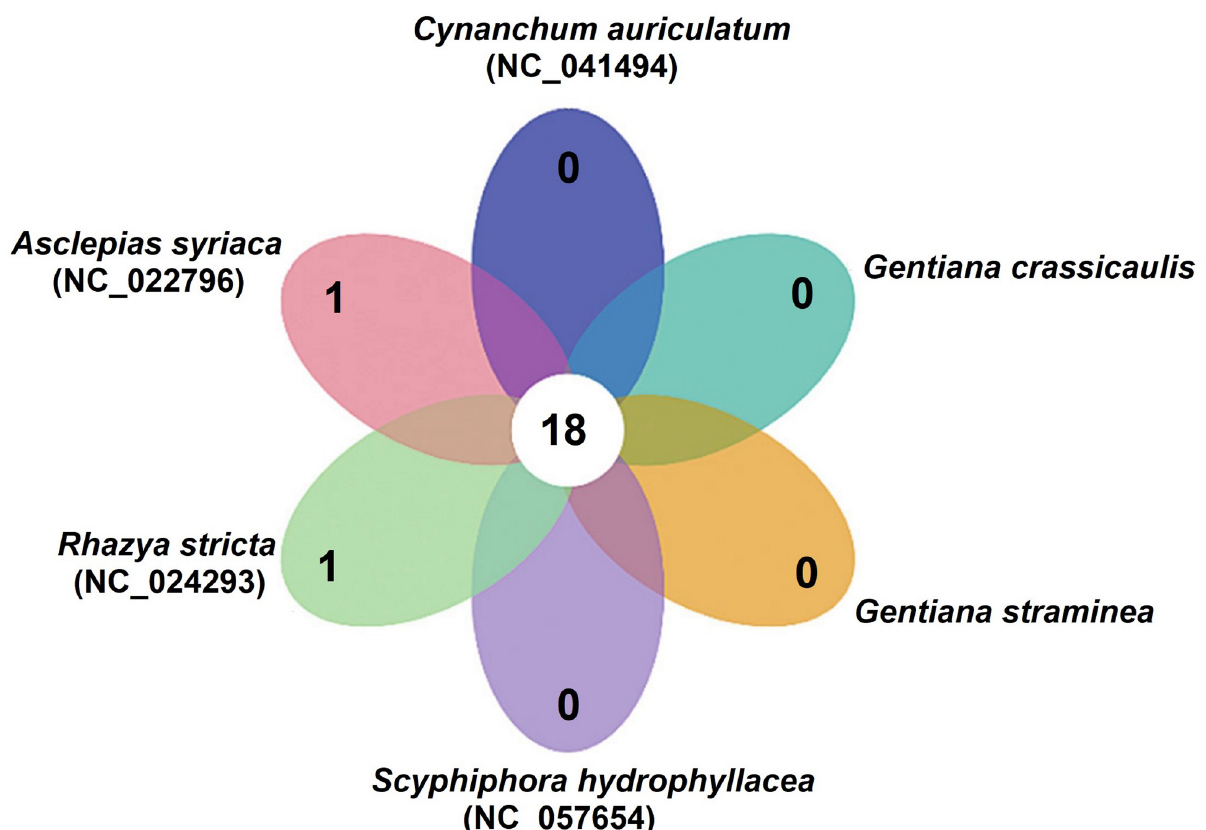
Fig 8. Core and specific genes of six Gentianales